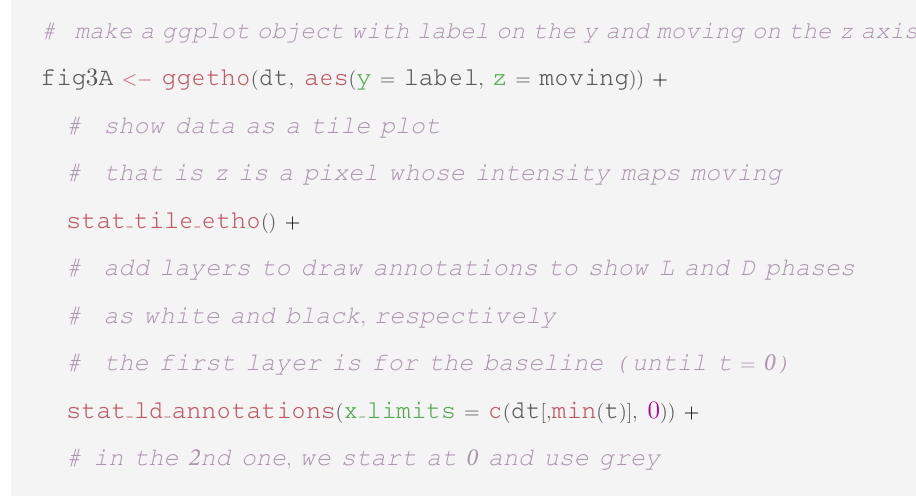
# make a ggplot object with label on the y and moving on the z axis fig 3 A < (cid:0) gg etho ð dt